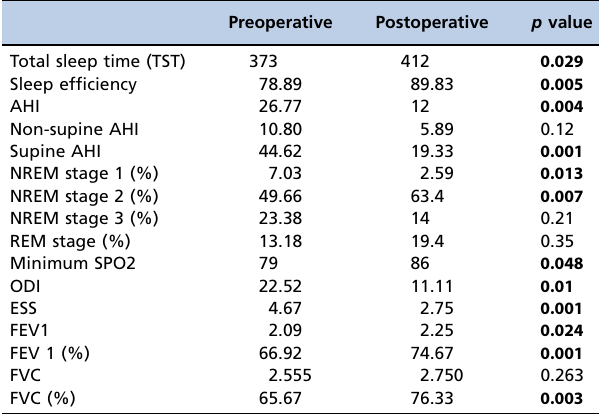
Table 2 - Preoperative and postoperative PSG and PFT